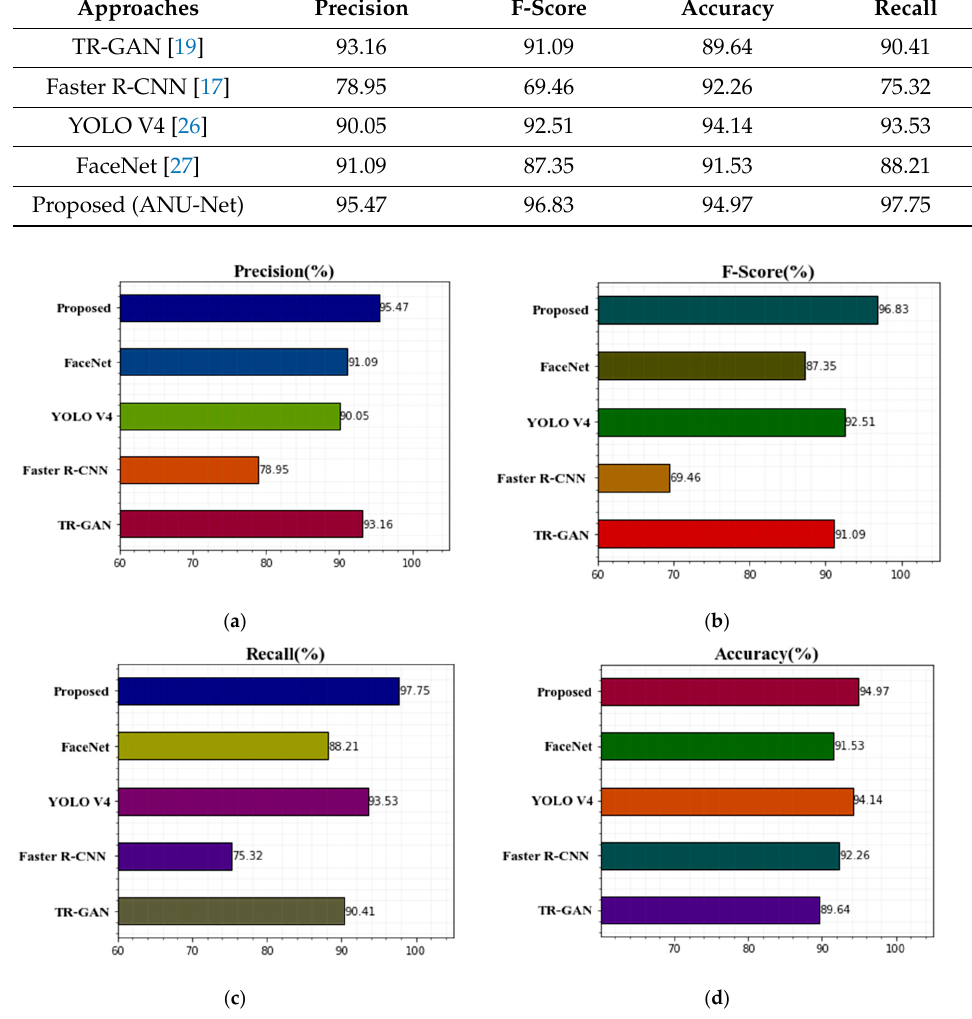
Table 3. Using the proposed and compared approaches, calculate precision, F-score, accuracy, and recall (%) without optimization.